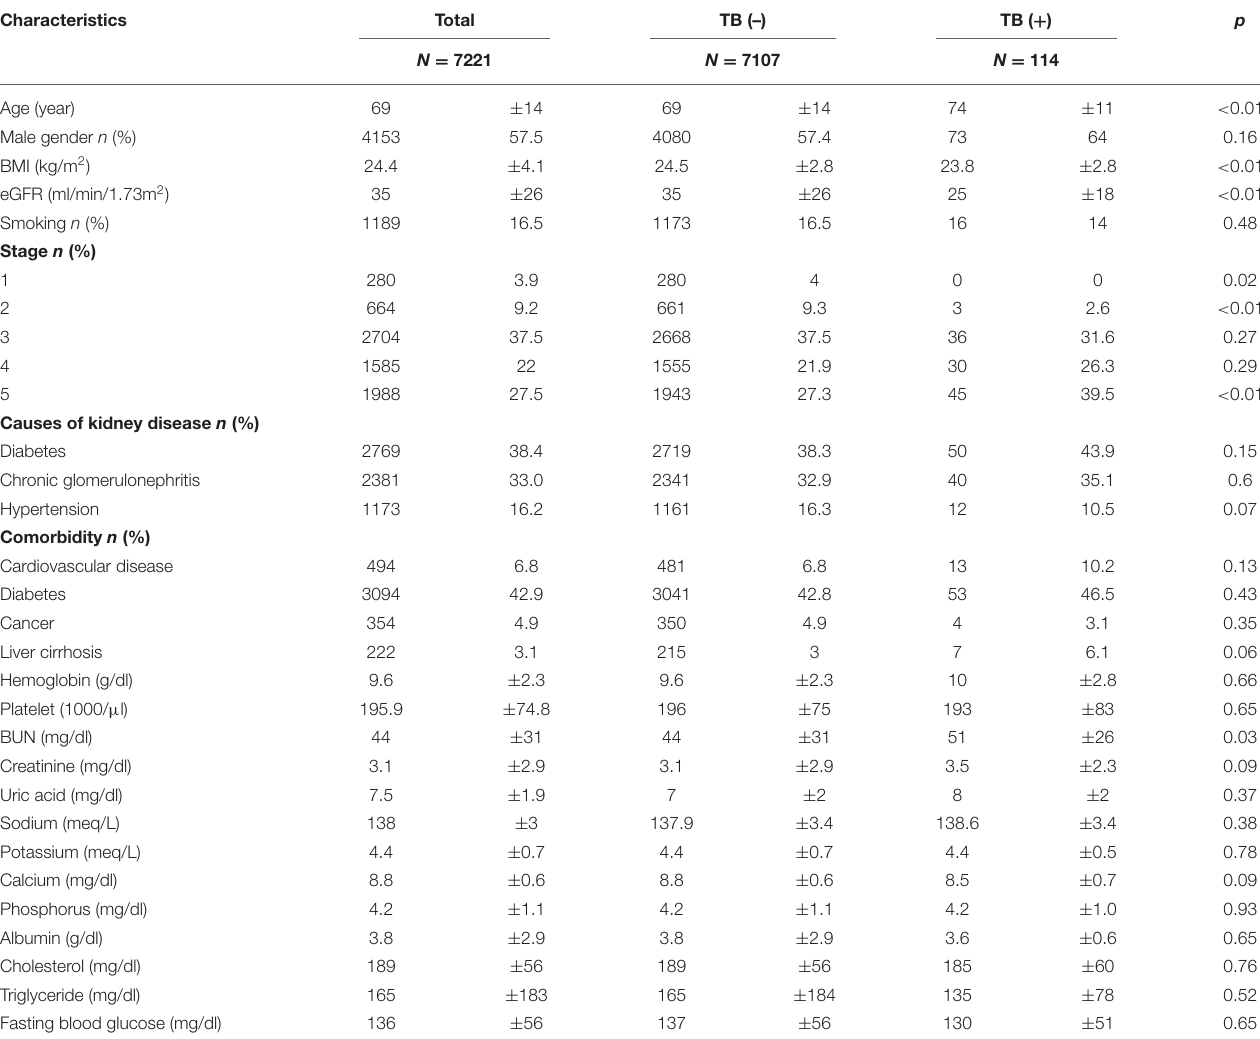
TABLE 1 | Clinical characteristics of patients with and without tuberculosis (TB).